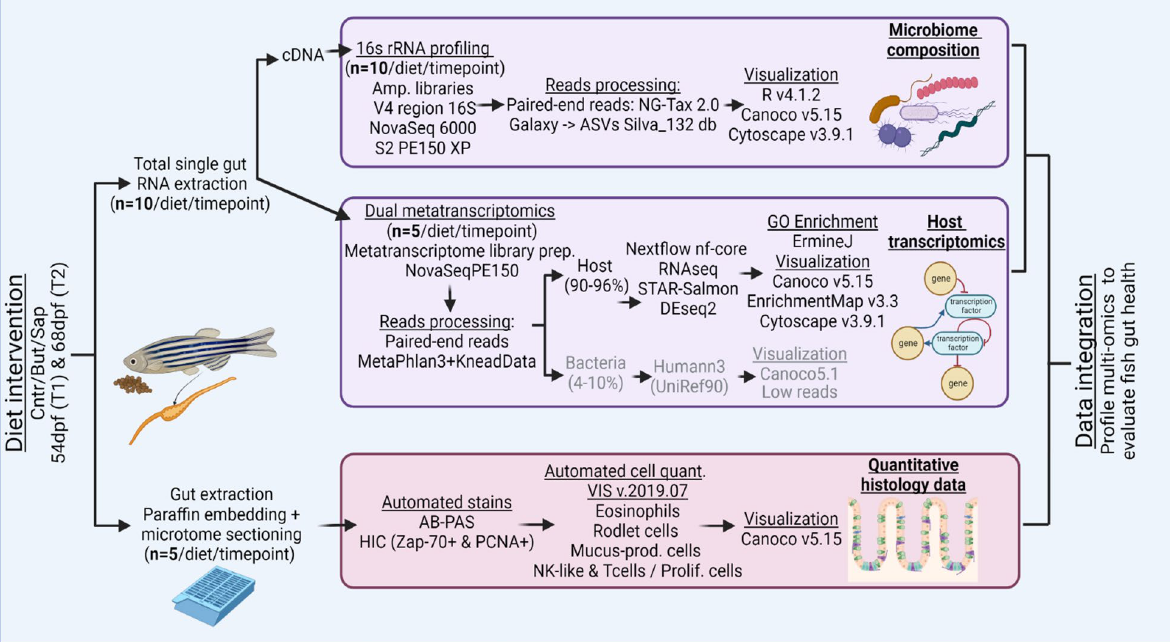
Fig. 2 Combinatorial approach employed: total RNA was extracted from single zebrafish gut fed on different diets for both timepoints. Aliquots of total RNA were used for cDNA. For the 16S rRNA gene profiling, amplicon libraries of the V4 region of the 16S RNA gene were generated from the cDNA synthetized. NG-Tax 2.0 Galaxy was sued to obtain the ASVs. Several packages of R v4.1.2., Canoco v5.15 and Cytoscape v3.9.1 were used for results visualization. For transcriptomics, the cDNA libraries were sent to NovaSeq 6000 PE150 for sequencing. MetaPhlAn 3.0 (Beghini et al. 2021) and KneadData were used to trim the overrepresented sequences. Nf-core/rnaseq Nextflow pipeline was used for processing of the reads with the GRCz11 genome assembly. The results were visualized by R v.4.1.2, Canoco v5.15 and ErmineJ was used for the GO Enrichment analysis. The histological samples were extracted and embedded in paraffin and sectioned using a microtome. AB-PAS and HIC stains were automated. Samples were digitally scanned and an automated quantification of the histological parameters was performed using VIS v.2019.07 and Canoco v5.15 and GraphPad Prism v9.0.0 to visualize the results. The data integration was performed using heatmaps of normalized relevant parameters from all datasets, both timepoints and all